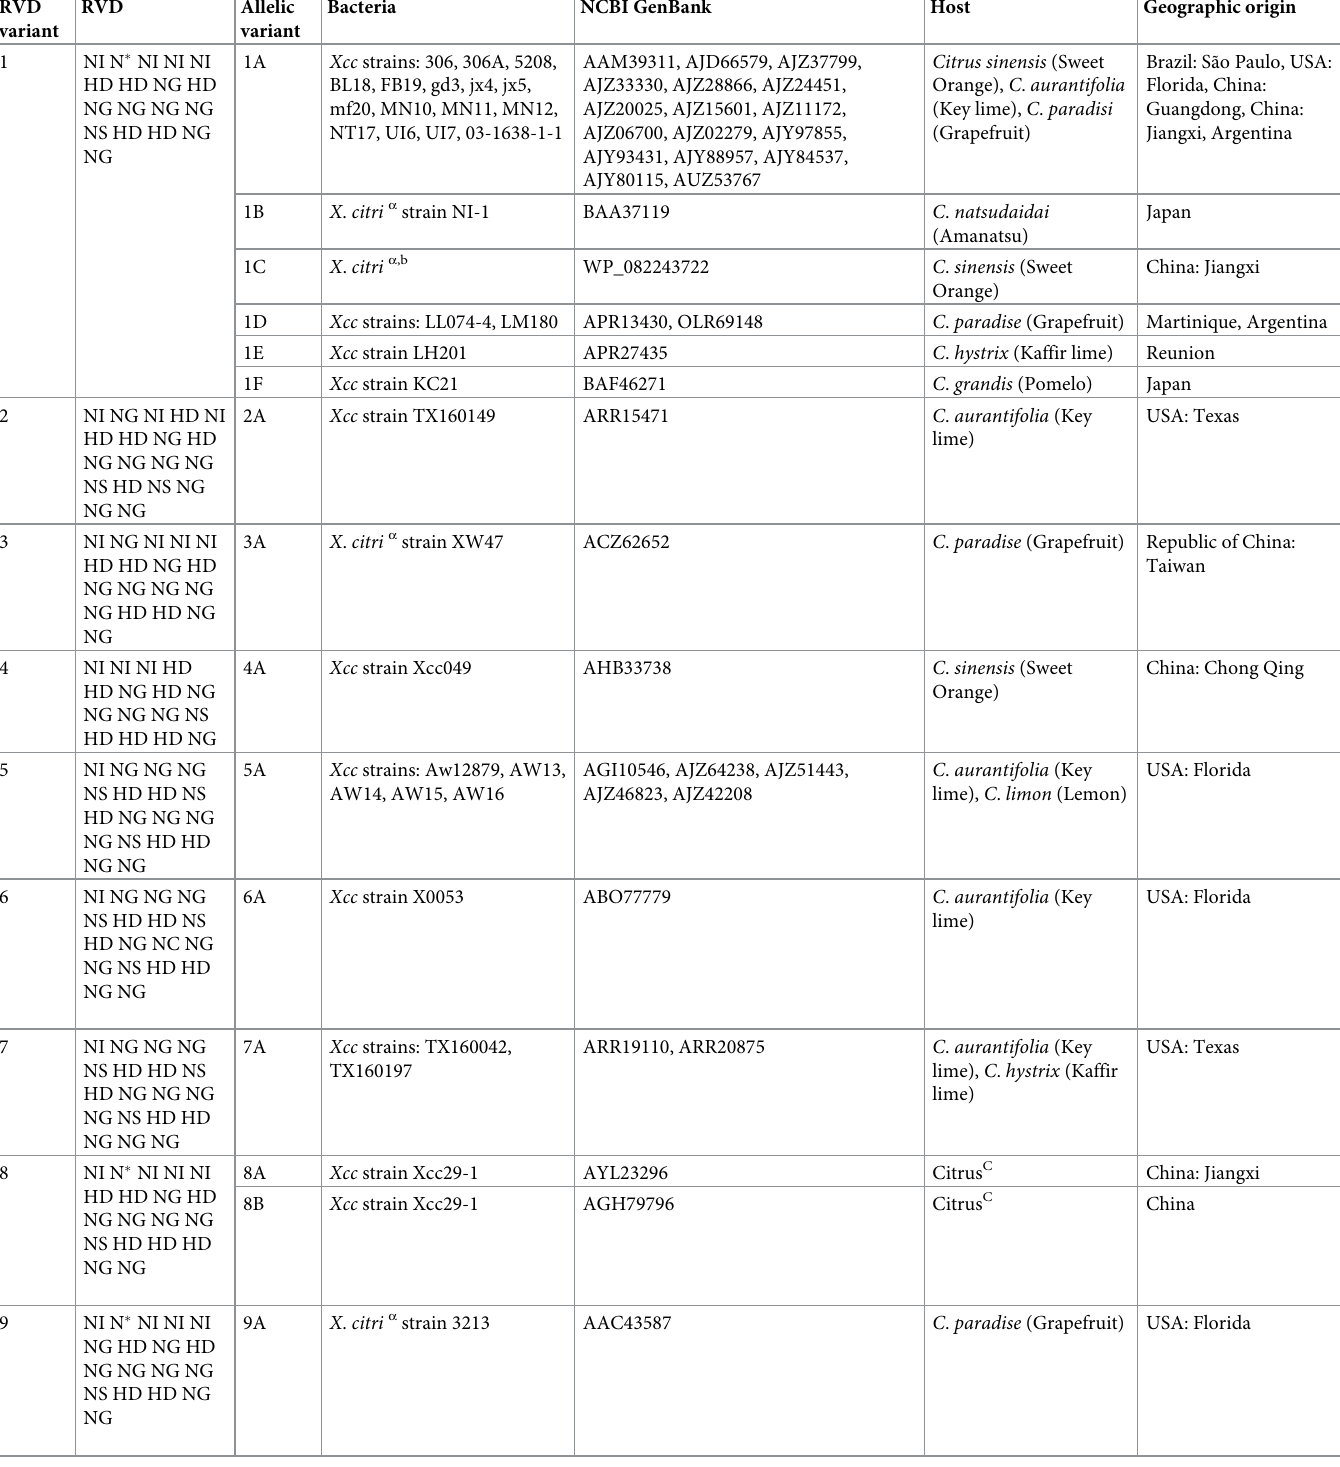
Table 1. Natural variations among TALEs targeting CsLOB1